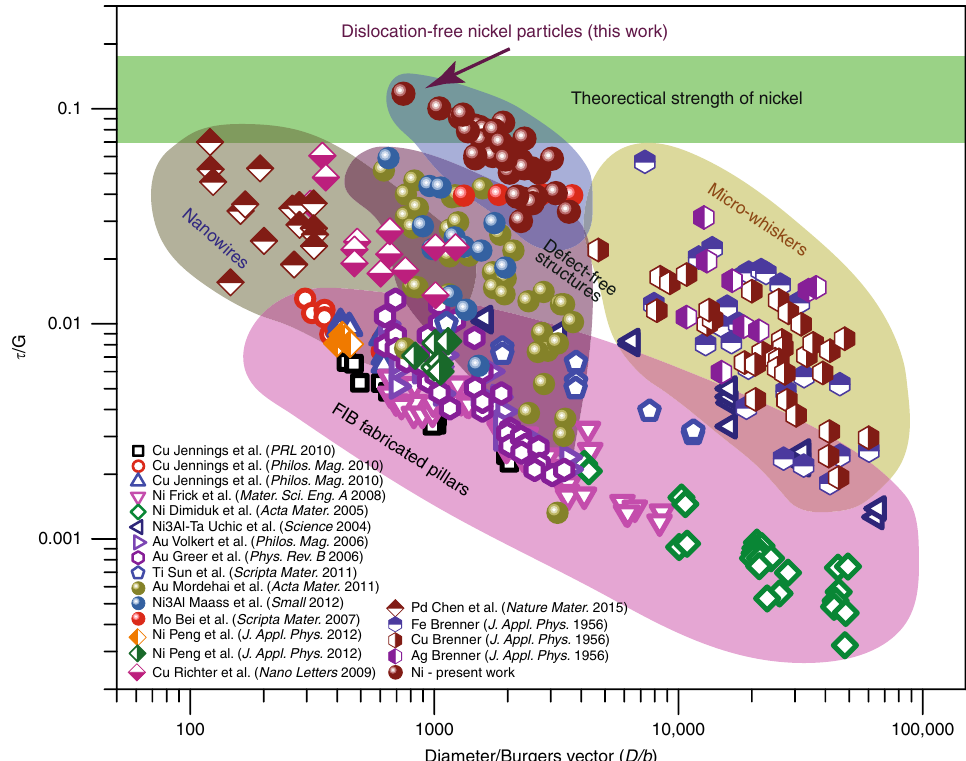
Fig. 4 Ashby plot of CRSS τ versus diameter D for Ni nanoparticles. The normalized CRSS measured in this work is compared with literature data for pillars, whiskers, nanowires, and particles of FCC and body-centered cubic metallic materials. The lower and upper bounds of the theoretical strength of Ni were obtained by fi rst-principles calculations 30 for the {111} 〈 112 〉 slip and from the Frenkel model 29 for the {111} 〈 110 〉 slip,